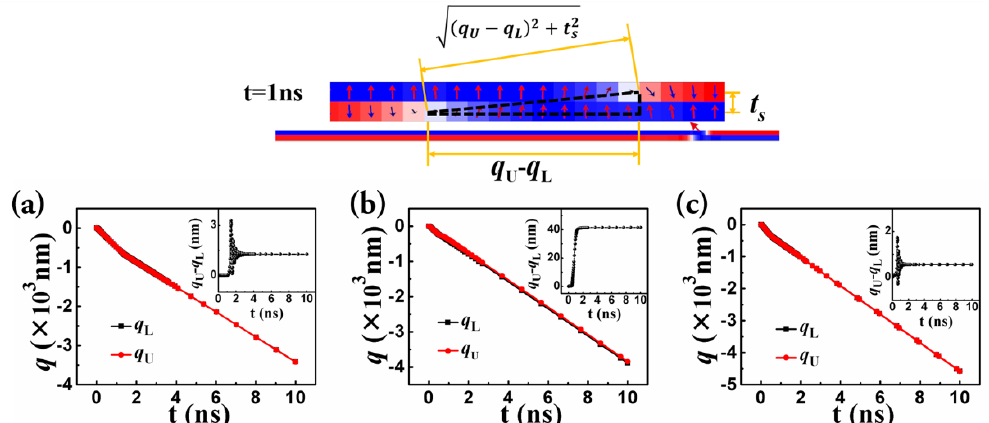
Figure 7. The evolution of the central positions of the lower layer ( q L ) and that of the upper layer ( q U ) for ( a ) K L = K U = 6 × 10 5 J / m 3 , and J ex = − 0.3 mJ / m 2 , ( b ) K L = 2 × 10 5 J / m 3 and K U = 6 × 10 5 J / m 3 , and J ex = − 0.3 mJ / m 2 , and ( c ) K L = 2 × 10 5 J / m 3 and K U = 6 × 10 5 J / m 3 , and J ex = − 0.75 mJ / m 2 . The upper panel indicates the inter-DW exchange coupling that was considered in the CCM.